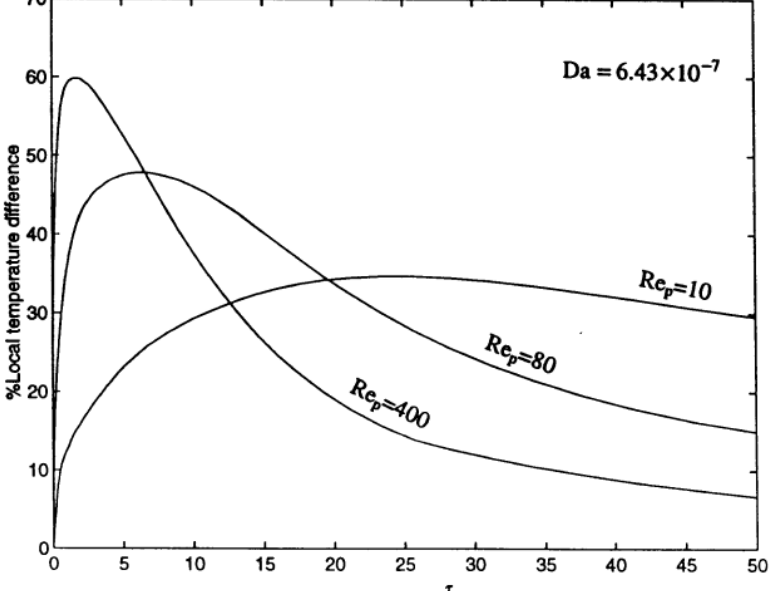
Figure 17. Instant influence of Reynolds number of the transient % LTE at Darcy number of (Da = 6.43 × 10 − 7 ), and thermal conductivity ratio ( k s / k f = 12), reported by Amiri and Vafai